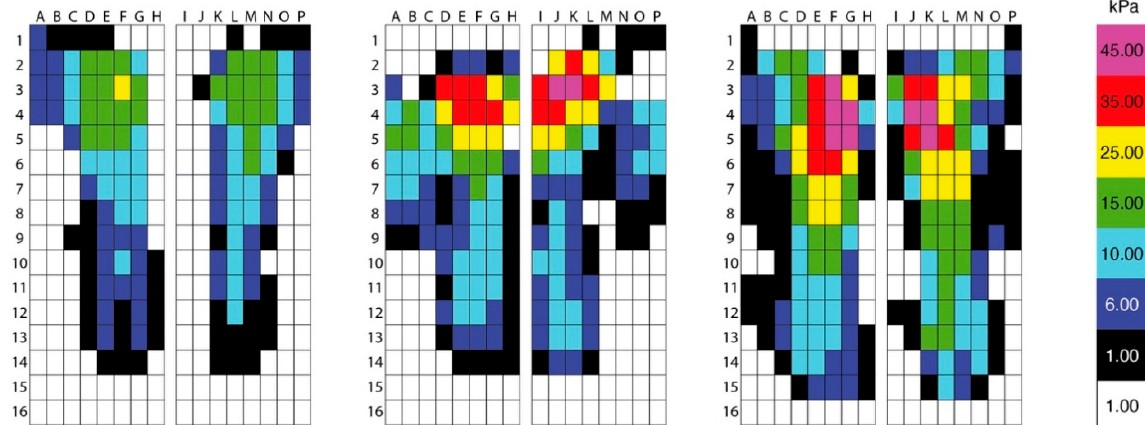
Figure 5. Illustrating pressure distribution beneath three saddles: left = correct saddle width; middle = narrow saddle width; right = wide saddle width from three horses who had the highest mean and peak saddle pressures (kPa) during the standardised ridden exercise test. The mean and peak saddle pressure data were collected during straight-line locomotion